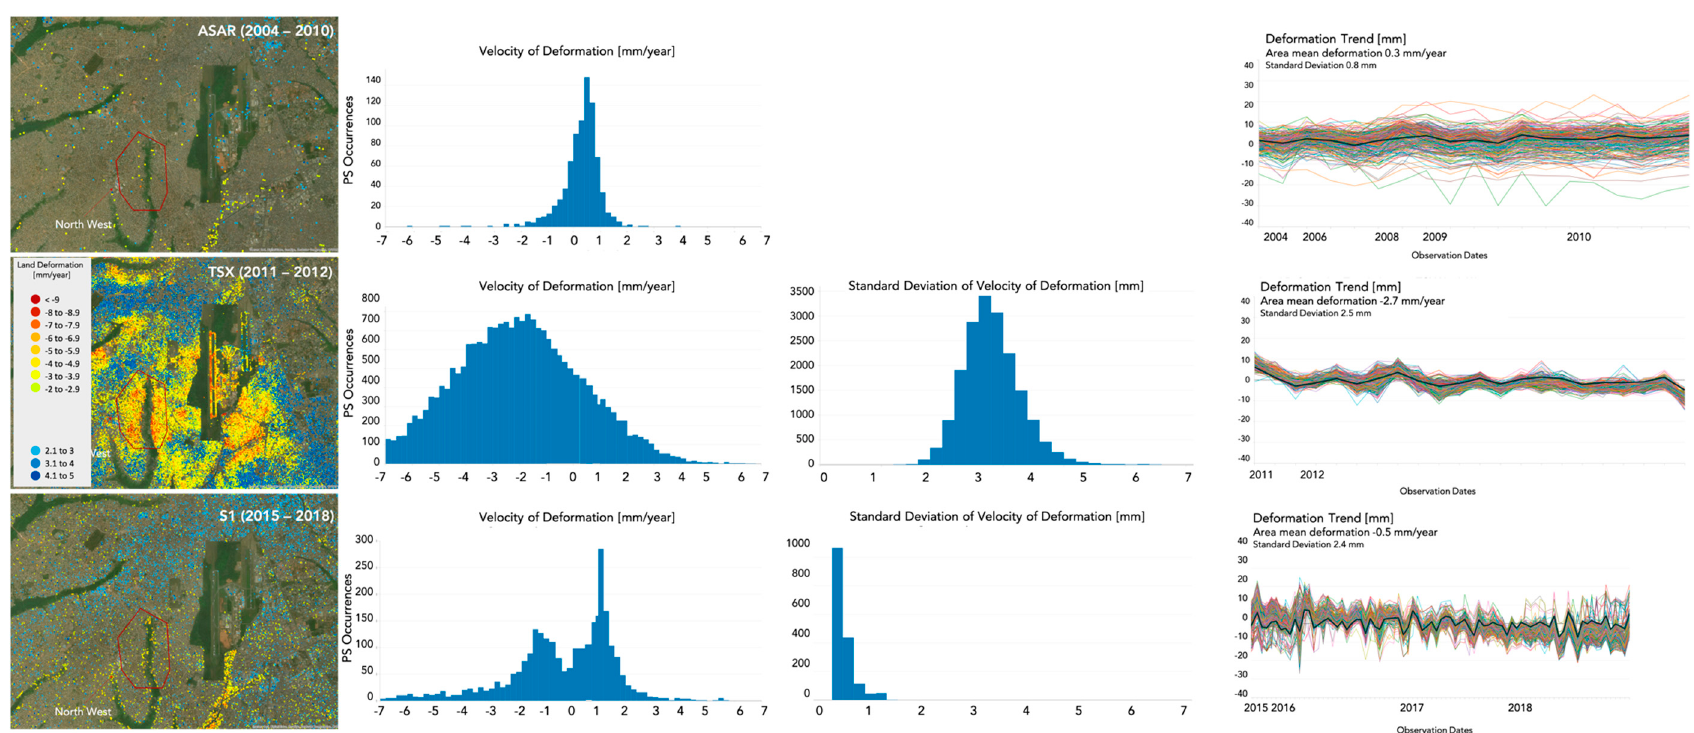
F igure 10. Lagos AOI 5. Figure 10. Lagos AOI